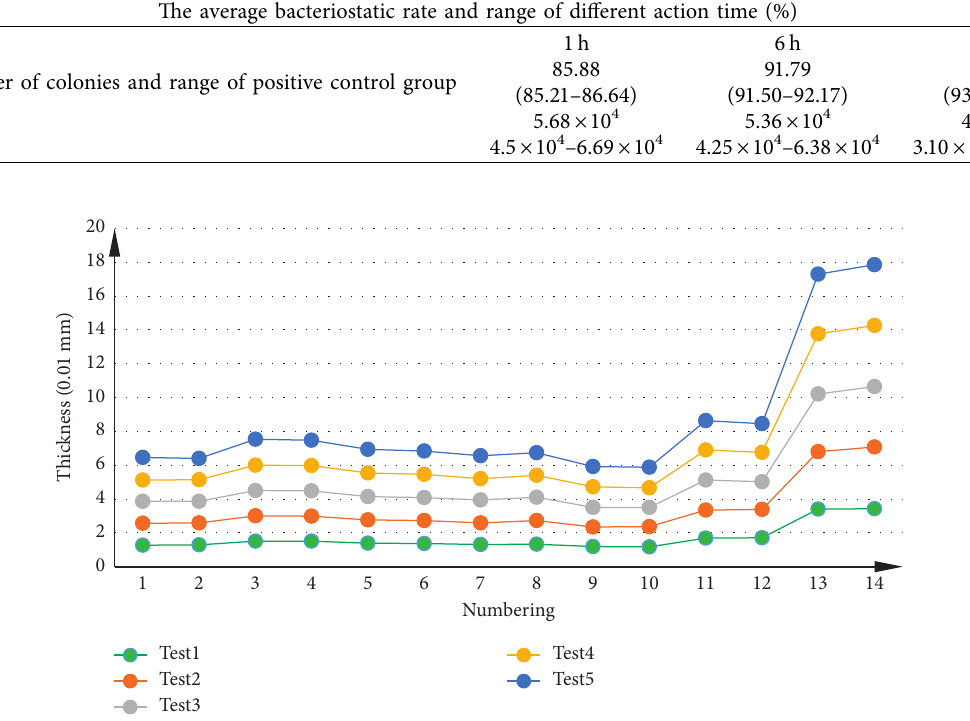
Figure 4: Comparison of average diameter of fabric